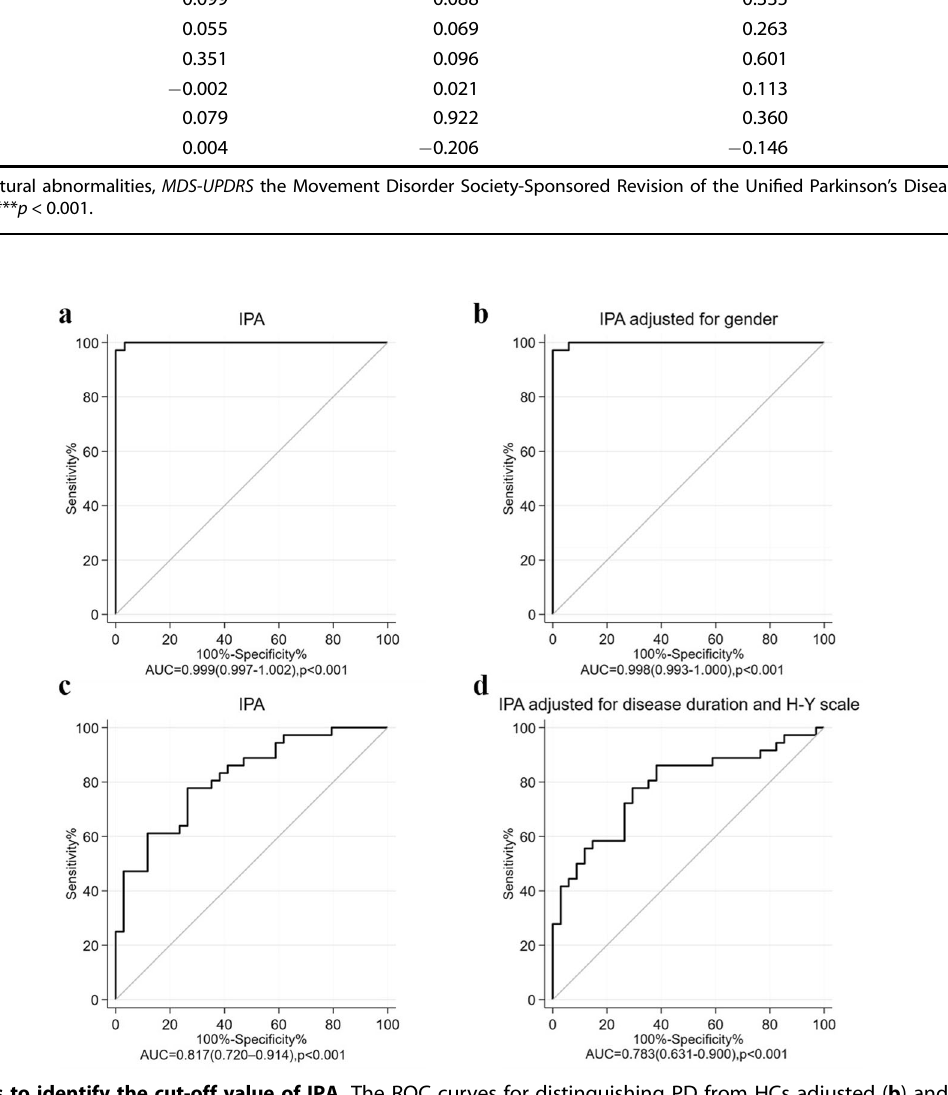
Fig. 4 ROC analysis to identify the cut-off value of IPA. The ROC curves for distinguishing PD from HCs adjusted ( b ) and not adjusted for gender ( a ). The ROC curves for distinguishing PwPA from PwtPA adjusted ( d ) and not adjusted for disease duration and H-Y scale ( c ). PD Parkinson ’ s Disease, PwtPA PD without postural abnormalities, PwPA PD with postural abnormalities, HCs healthy controls, IPA the index for postural abnormalities, H-Y scale Hoehn-Yahr